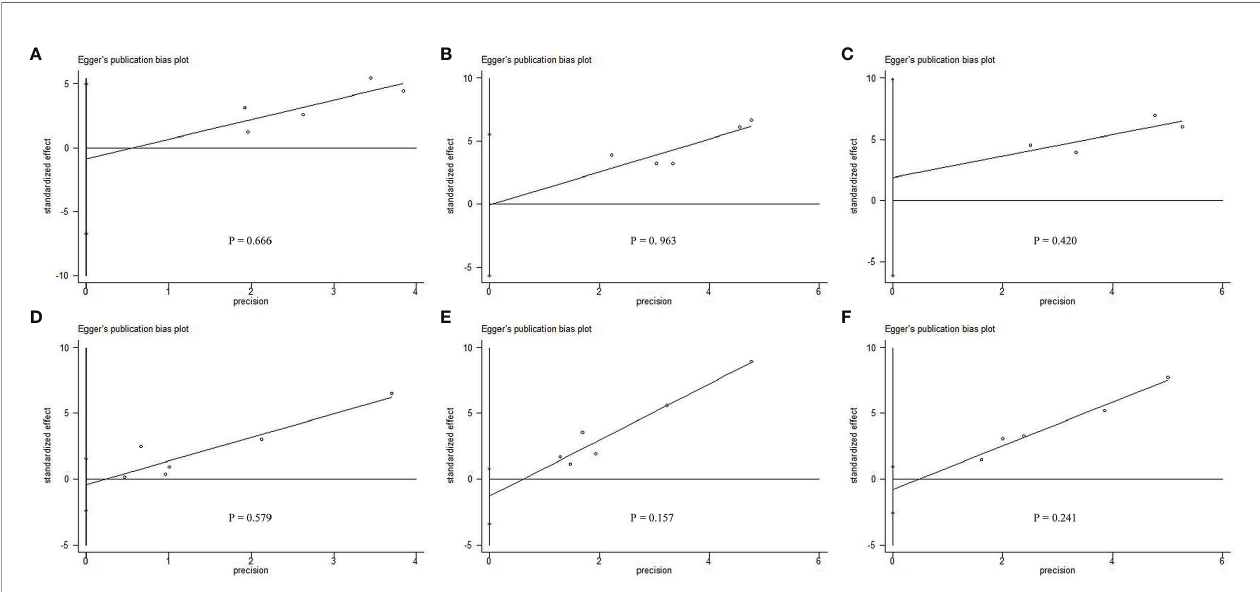
FIGURE 4 | Egger linear regression test does not indicate any evidence of publication bias. Egger linear regression with pseudo 95% con fi dence limits using (A) 1-year DFS, (B) 3-year DFS, (C) 5-year DFS, (D) 1-year OS, (E) 3-year OS, and (F) 5-year OS, revealed that there was no signi fi cant difference in potential publication bias on the results of our